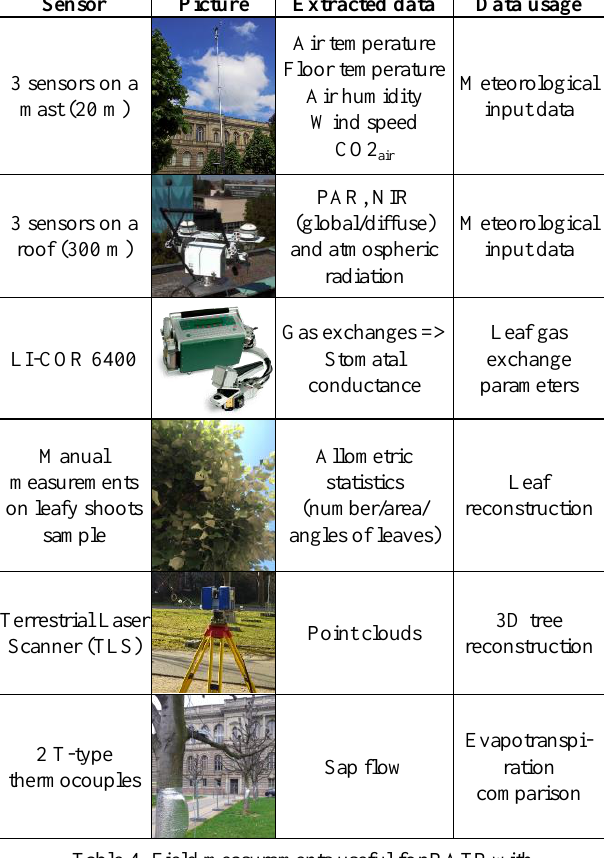
Table 4. Field measurements useful for RATP with corresponding sensors